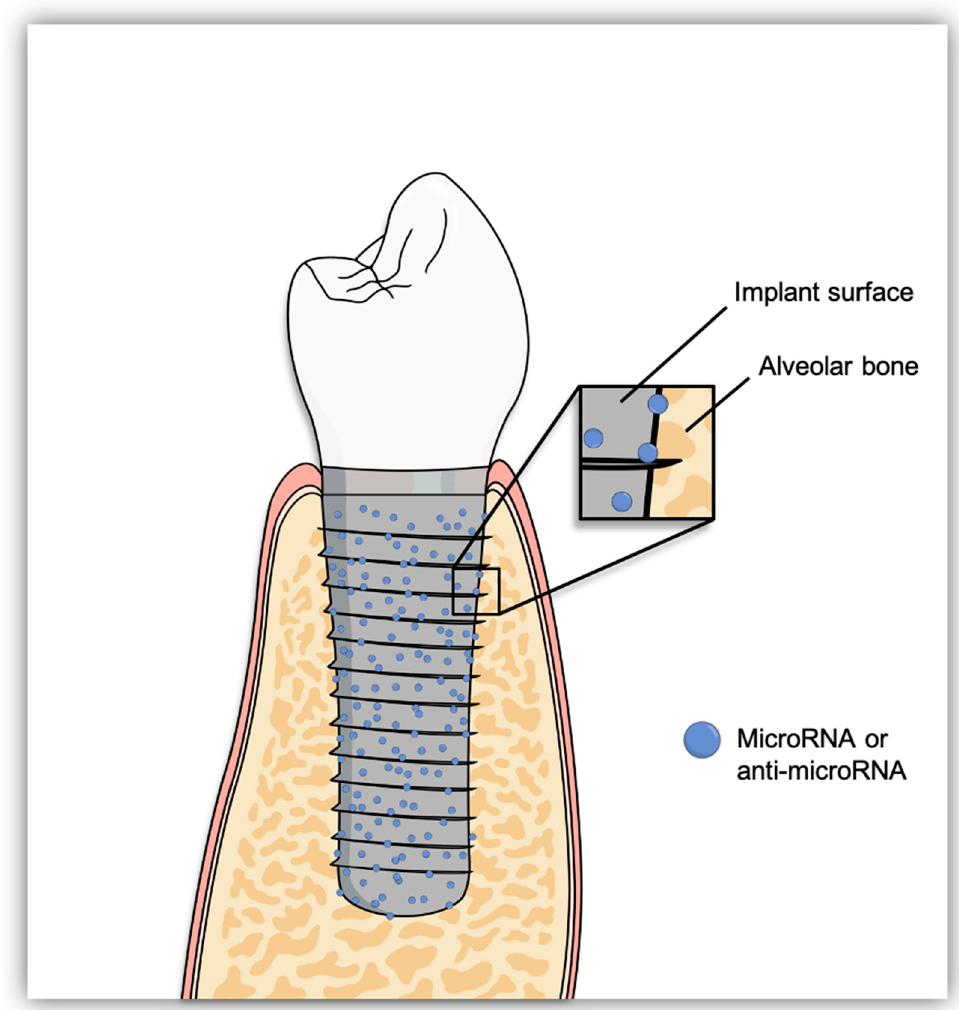
Figure 3. Dental Implant surface coated with microRNA or anti-microRNA to enhance osseointegration.